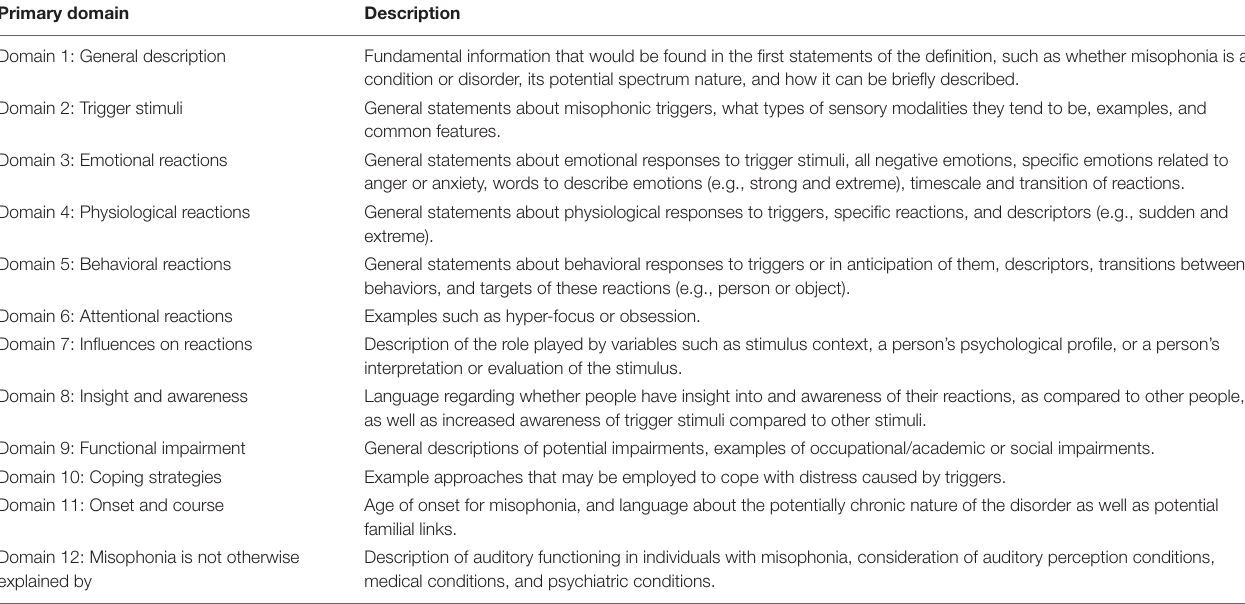
TABLE 3 | Twelve primary domains of criteria about misophonia were identified during the literature review. Primary domain